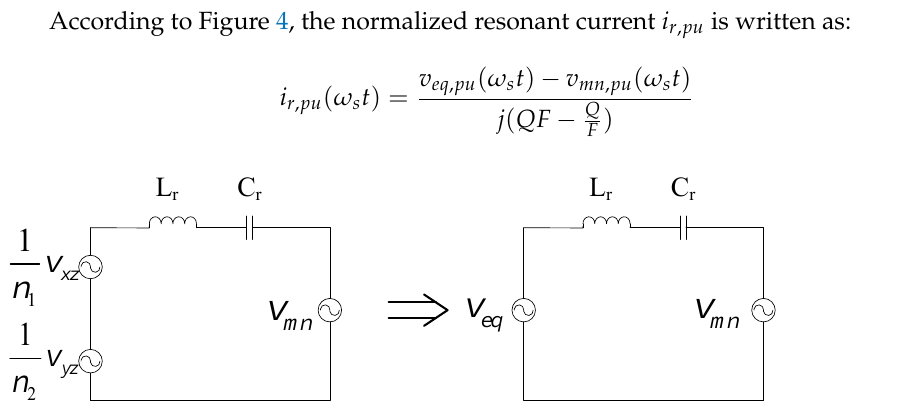
Figure 4. The FHA equivalent circuit of the